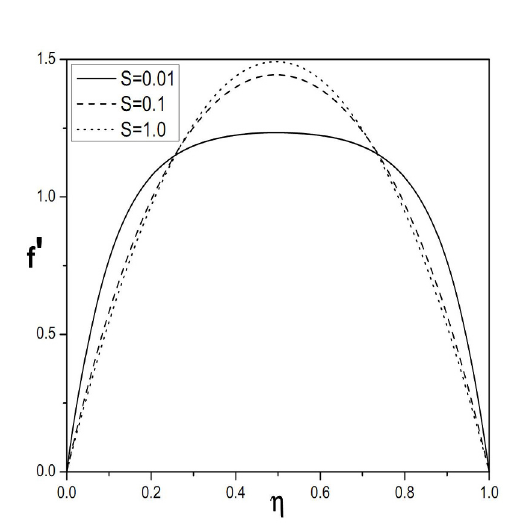
Figure 6. Effect of magnetic parameter M on axial velocity when Re = 0 . 5 . = 0 . 5 .